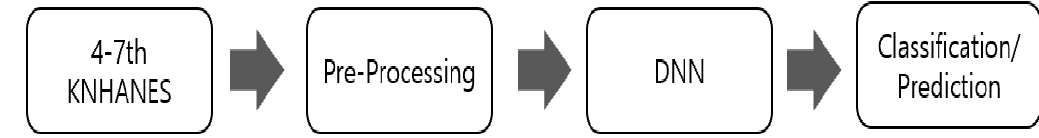
Figure 2. Flow chart of the proposed method for classification and prediction. DNN, Deep Neural Network; KNHANES, Korea National Health and Nutrition Examination Survey.